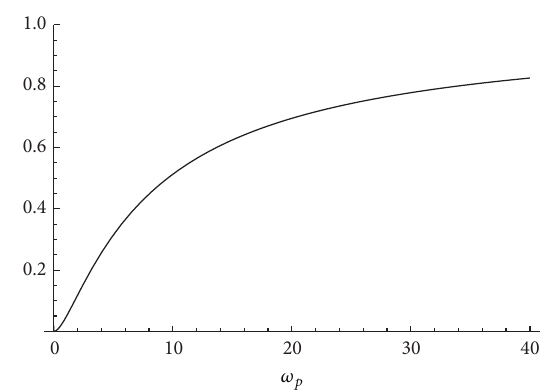
Figure 3: The function F 1 (𝜔 𝑝 ) normalized to its value F 1 (∞) = −𝜁(3)/4𝜋 2 , (189), at infinite 𝜔 𝑝